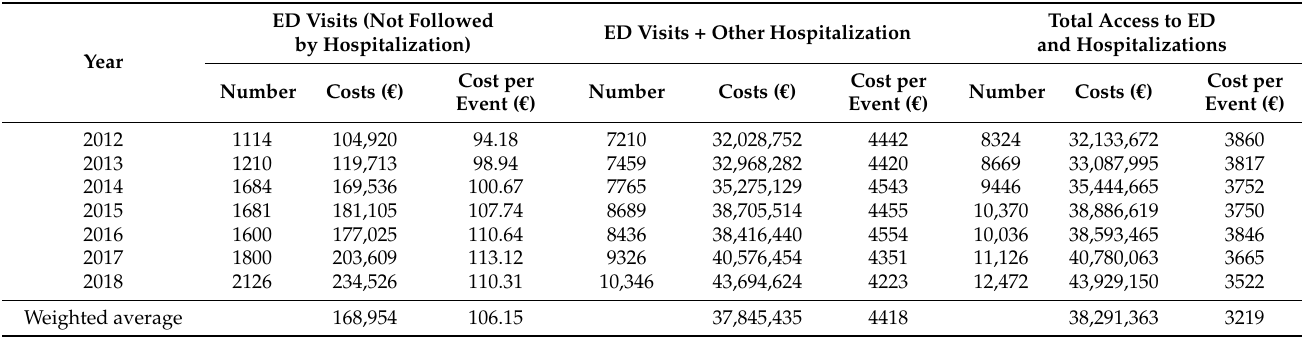
Table 2. Healthcare resource utilization and costs for all-cause pneumonia for subjects ≥ 15 years of age in the Liguria region 2012–2018.